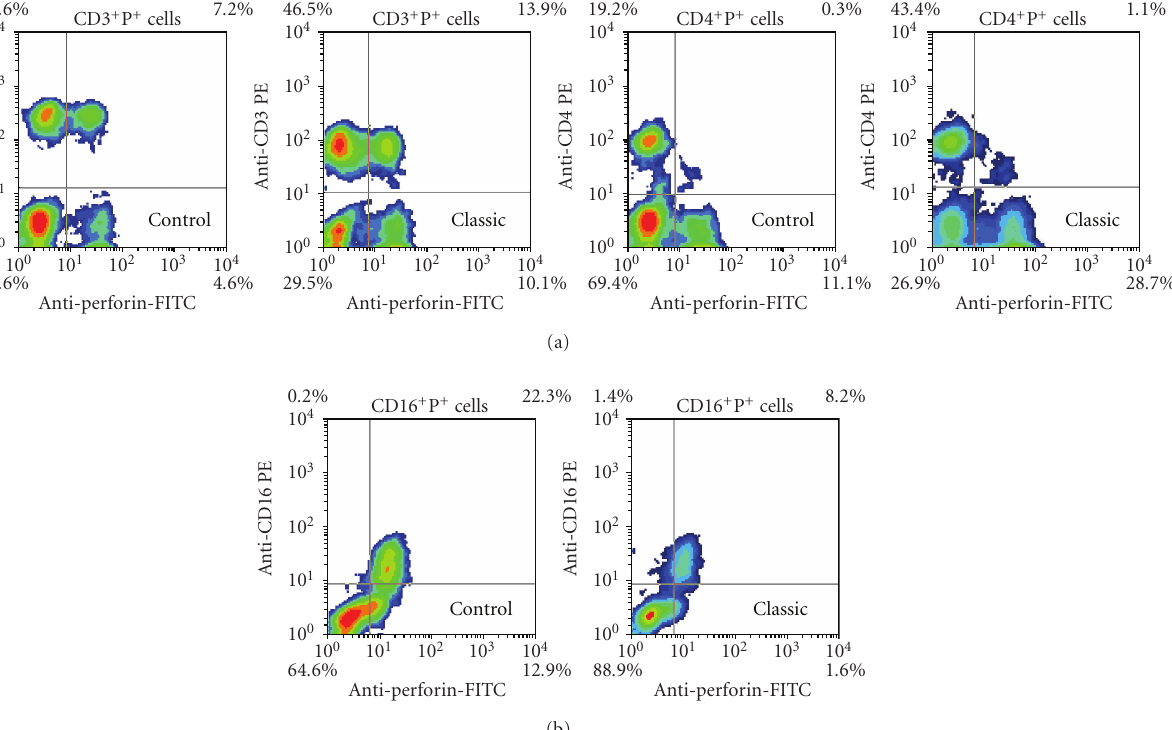
Figure 4: Representative two color analysis of PBMNLC for perforin (horizontal) and cell surface phenotype (vertical) in healthy persons and patients elected for classic cholecystectomy. (a) Subpopulations of T lymphocytes (CD3 + P + and CD4 + P + ); (b) subpopulation of NK cells (CD16 + P +